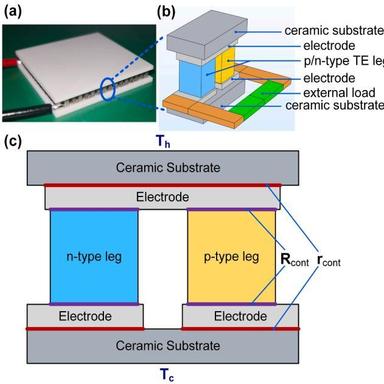
Picture of a (a) thermoelectric generator module and schematic diagrams of a (b) thermoelectric couple and (c) its inner structure.